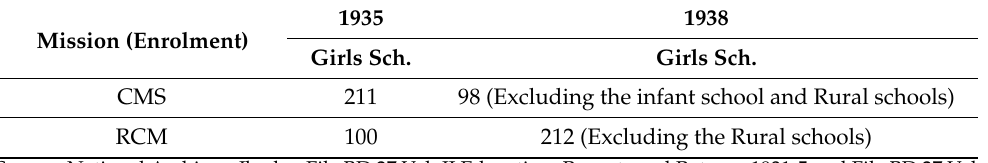
Table 2. Increase in the number of Girls registered in Christian Mission-owned Girl’s Only Schools. 1935 1938 Mission (Enrolment) Girls Sch. Girls